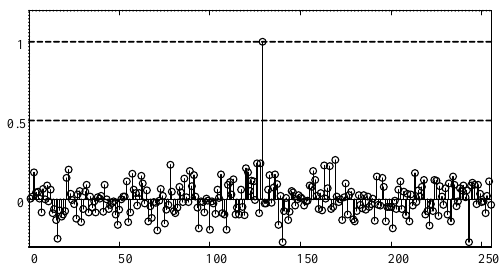
Figure 4. An example of a PCF vector (with noise).